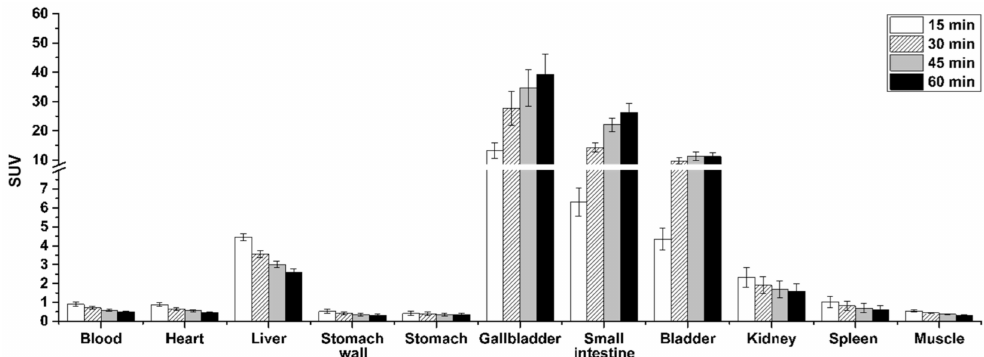
Figure 9. Biodistribution of [ 18 F] TOZ1 at different time points based on PET imaging ( n = 7, mean SUV ±